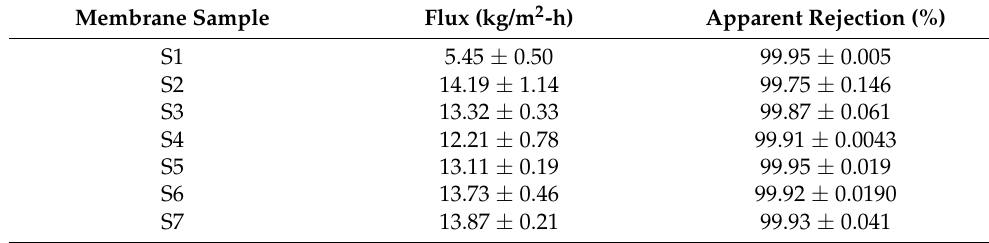
Table 3. Average water flux and apparent rejection for 24 h operation by DCMD on 35 g/L NaCl solution.